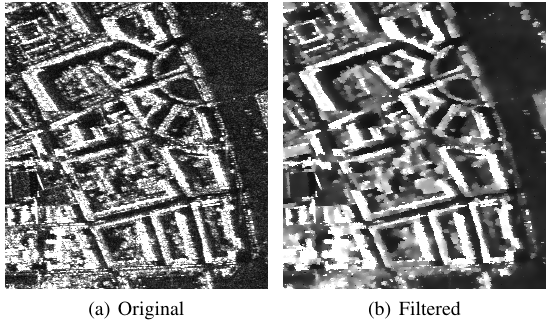
Figure 6: Comparison of (a) original intensity image with speckle and (b) filtered image thanks to adaptive covariance estimation. The trace of the covariance matrix is displayed.